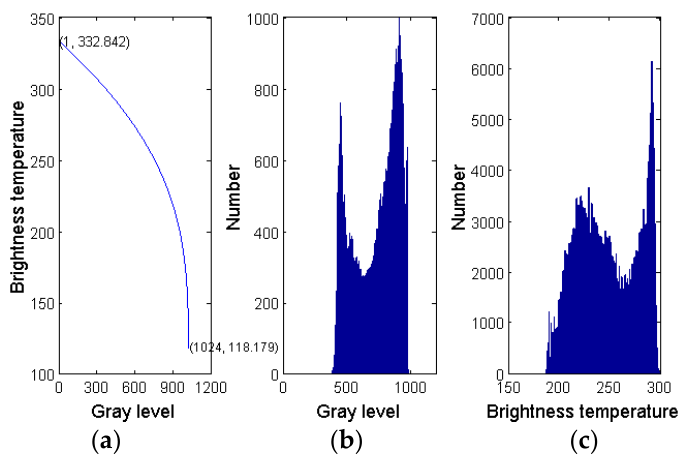
Figure 1. Analysis diagram of gray and brightness temperature. ( a ) Nonlinear curve for gray value and brightness temperature of IR1 image; ( b ) Gray histogram for IR1 image; ( c ) Top brightness temperature histogram of IR1 image. Table 1. The components of feature vector for cloud classification.